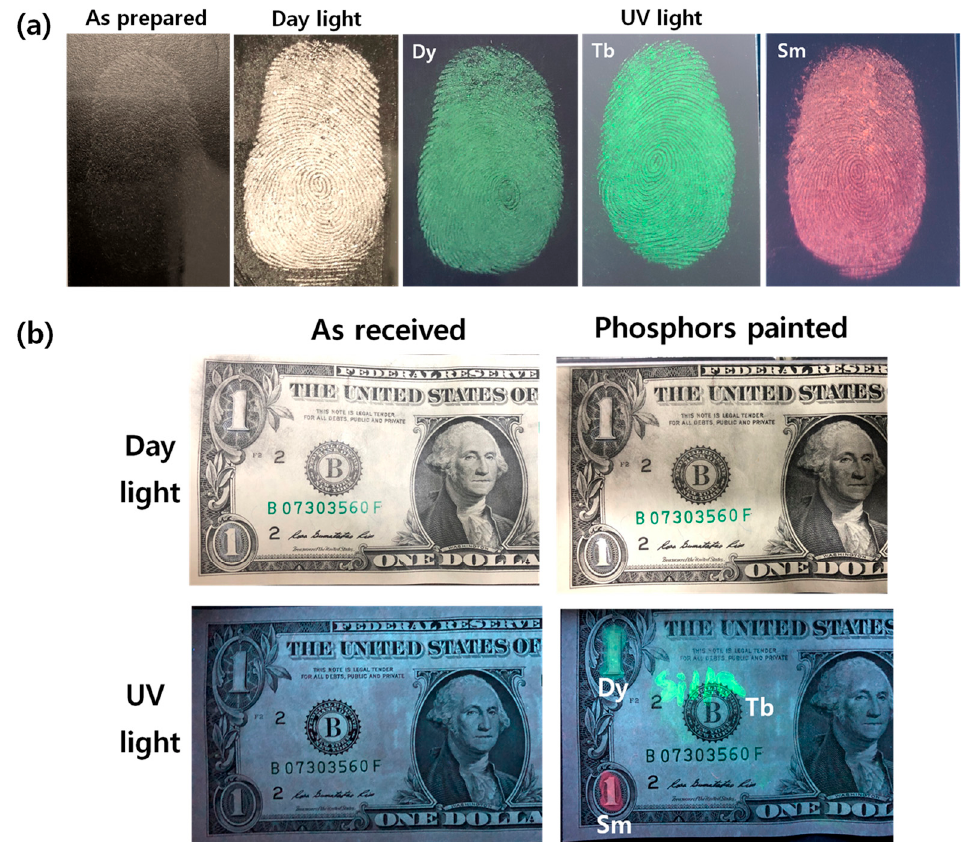
Figure 7. Images of phosphors ( a ) fingerprinted on glass substrates and ( b ) painted on the US dollar bank notes in daylight and under UV light.